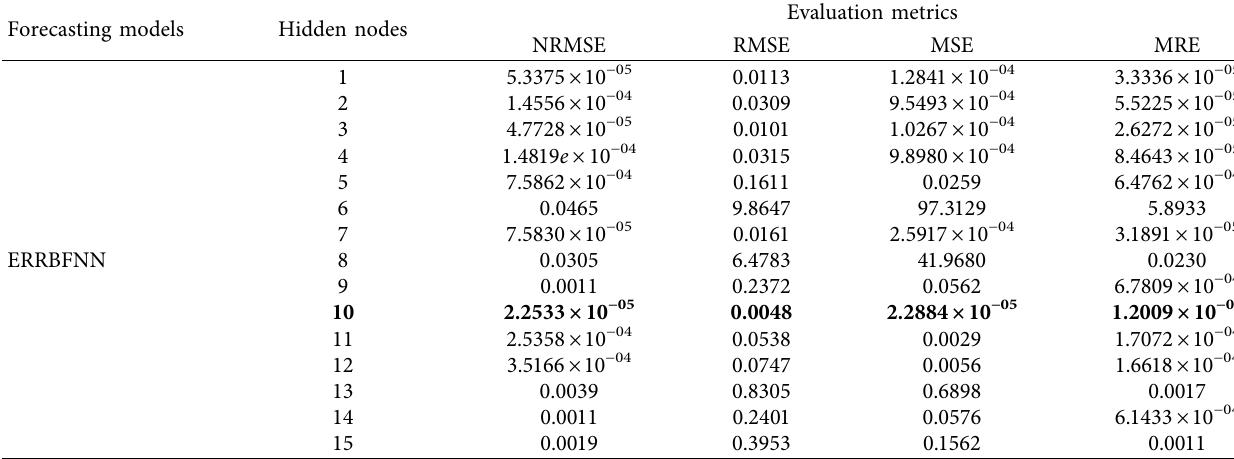
Table 4: Evaluation metrics of the proposed ERRBFNN model with various hidden nodes.